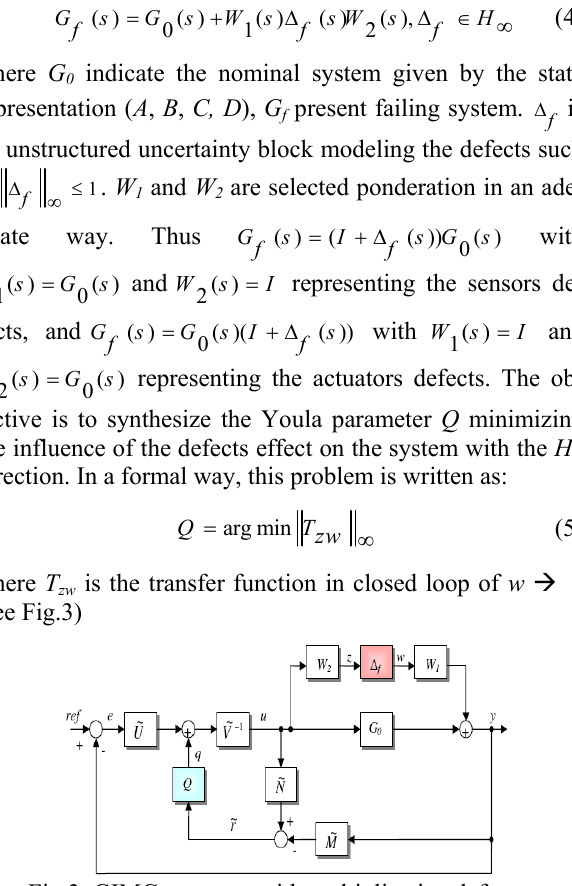
Fig.3. GIMC stru cture with multiplicative